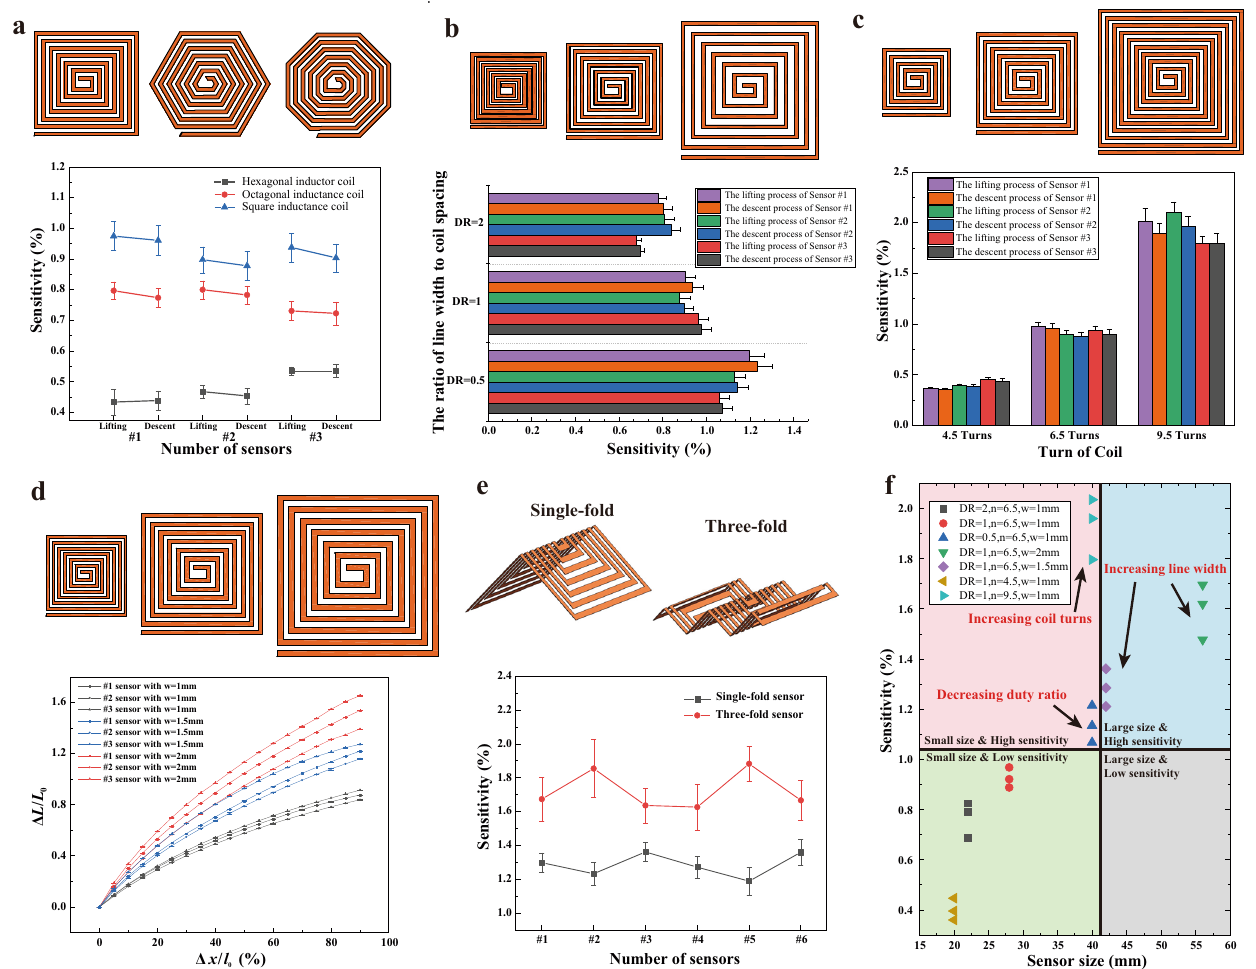
Fig. 5 Comparison and optimization of various parameters of PSIFS. a – e Schematic and sensitivity comparison of sensors with different coil shapes, duty ratio (DR), numbers of turns ( n ), line width ( w ), and numbers of folding units. f Comparison of the effect of different parameters on sensitivity-size two dimensions. The error bars in this fi gure are all de fi ned as standard